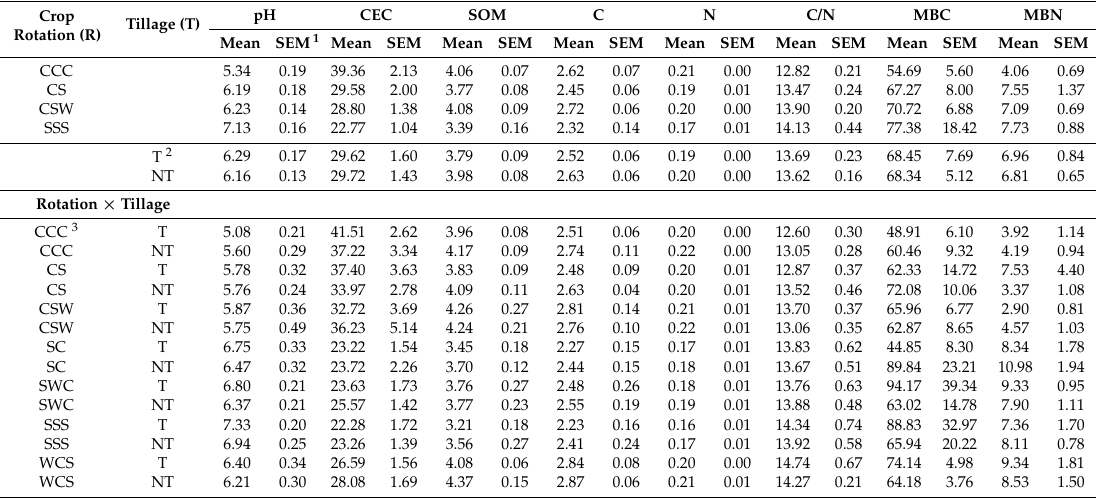
Table A6. Mean values of pH, cation exchange capacity (CEC, cmol kg − 1 ), soil organic matter (SOM, %), carbon (C, %), nitrogen (N, %), carbon to nitrogen ratio (C/N), microbial biomass carbon (MBC, µ g g − 1 ), and microbial biomass nitrogen (MBN, µ g g − 1 ), determined by crop rotation (R) and tillage (T) and for each R and T